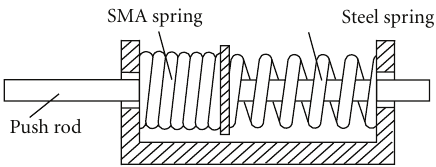
Figure 2: Operational principle of the SMA